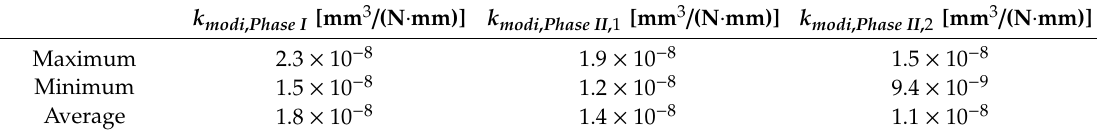
Table 4. Modified specific wear coe ffi